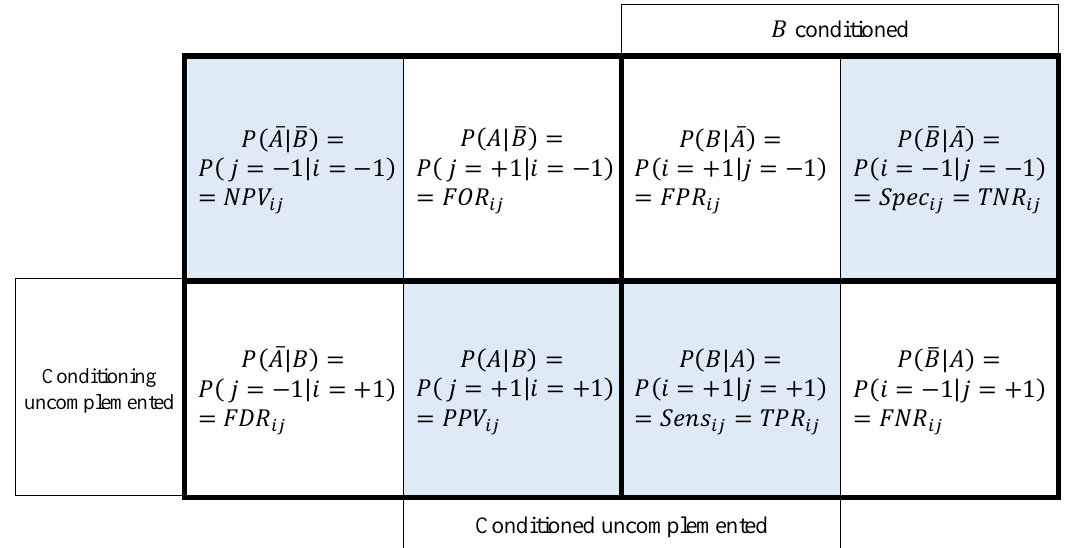
Figure 3. Definition of the eight conditional probabilities concerning events 𝐴 and 𝐵 . The four most prominent among them (lacking mixed polarity) are entered in shaded cell. The graph has four major cells, each containing two complementary